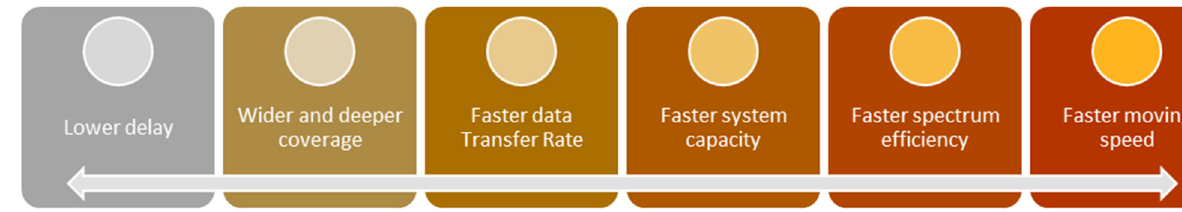
Figure 1. Achievements in Industry 4.0 with 5G and 6G.